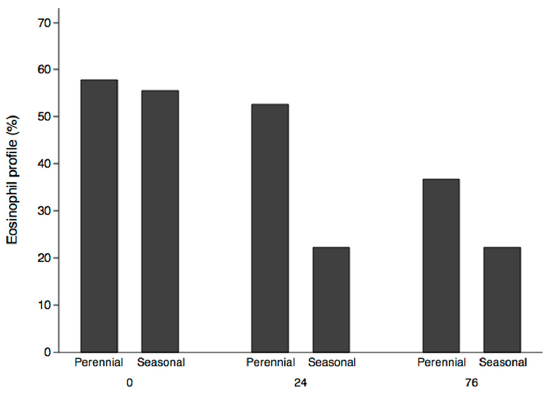
Figure 4. Changes in eosinophil profiles (more than 300 eosinophils/µL in peripheral blood) over the course of the study.